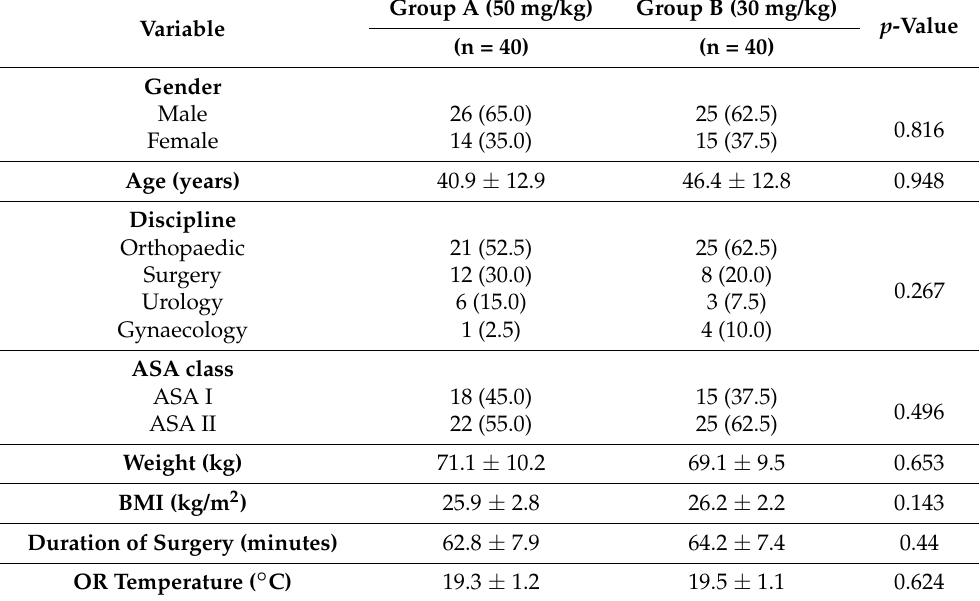
Table 1. Demographic data.